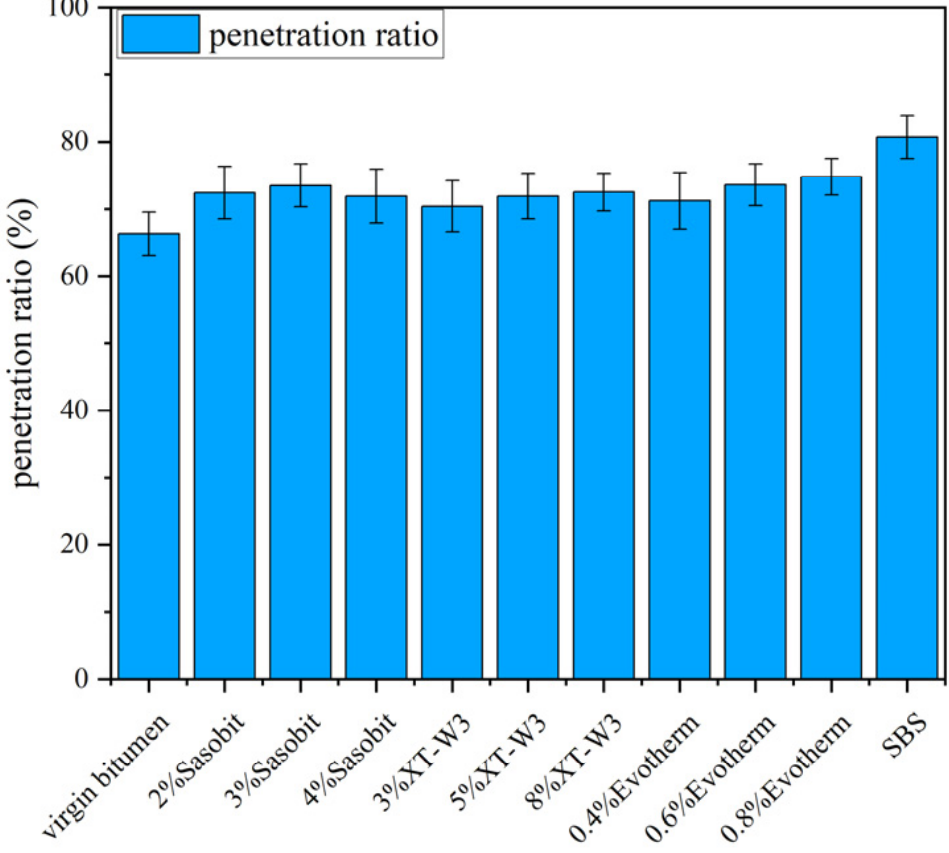
Figure 4. Penetration ratio of bitumen before and after aging.